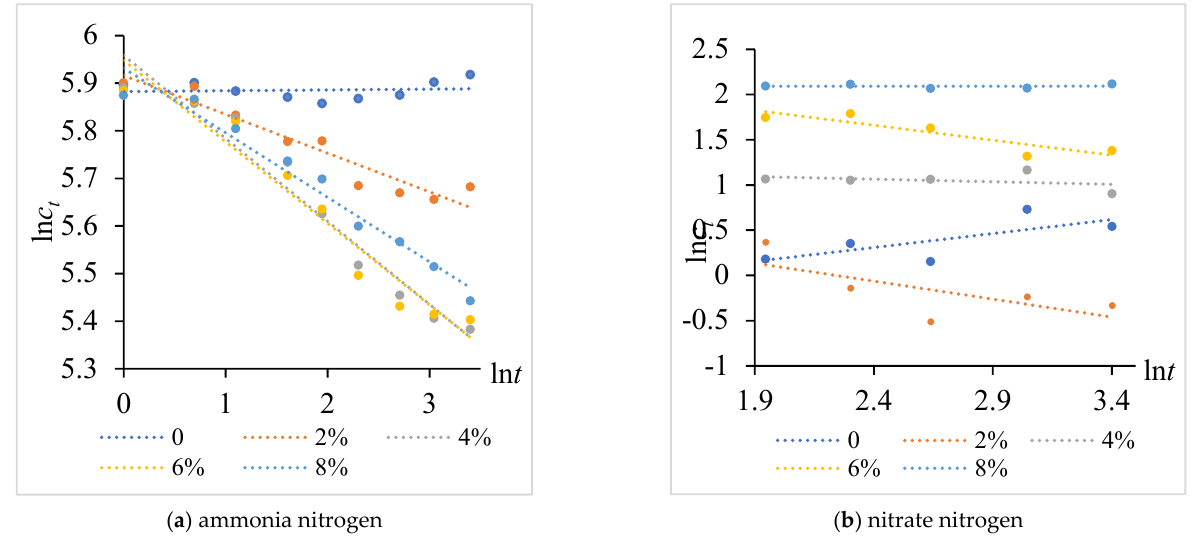
Figure 5. Double logarithm regression relationship between ammonia nitrogen/nitrate nitrogen content in sediment and test days. Table 2. Double logarithm linear expression between ammonia nitrogen/nitrate nitrogen content in sediment and test days.